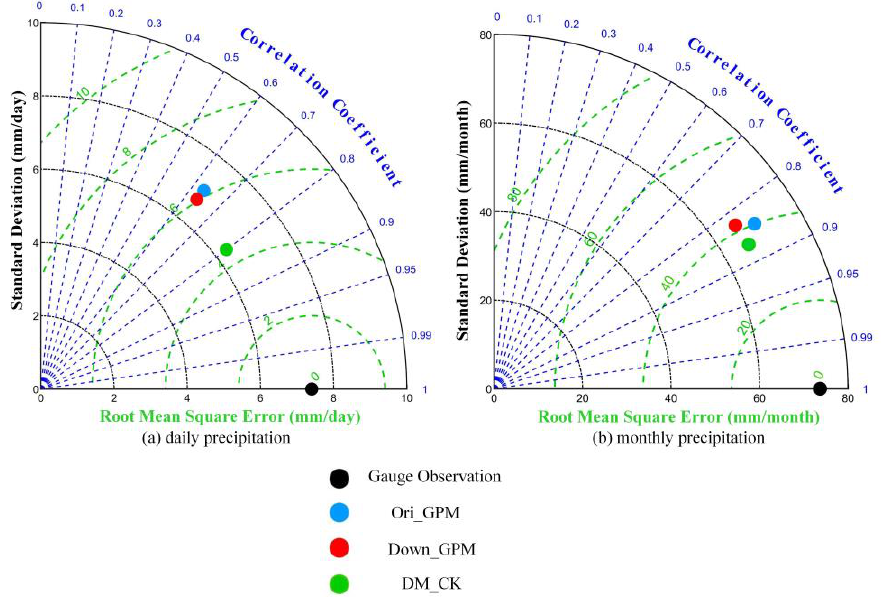
Figure 7. Taylor diagrams for daily precipitation and monthly precipitation of the gauge observation, Ori_GPM, Down_GPM, and DM_CK across the entire period from March 2016 to February 2018.